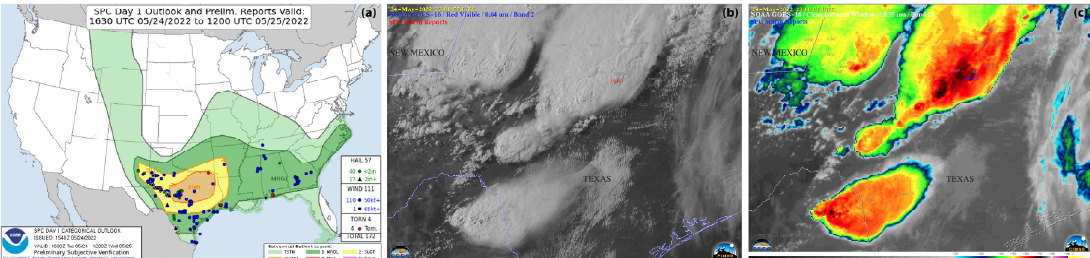
Figure 9. ( a ) Storm Prediction Center Categorical Outlook (https://www.spc.noaa.gov/products/ outlook/archive/2022/day1otlk_v_20220524_1630.gif, accessed on 10 September 2022) issued at 1548 UTC on 24 May 2022 valid for 1630 UTC until 1200 UTC the following day. Subsequent weather reports are indicated by the blue (wind) and green (hail) dots. ( b ) GOES-16 ABI visible (0.64 µ m) image at 23:00 UTC; ( c ) GOES-16 ABI infrared window (10.35 µ m) image at 23:00 UTC. Panels ( b , c ) are adapted from animations from https://cimss.ssec.wisc.edu/satellite-blog/archives/46521 (accessed on 10 September